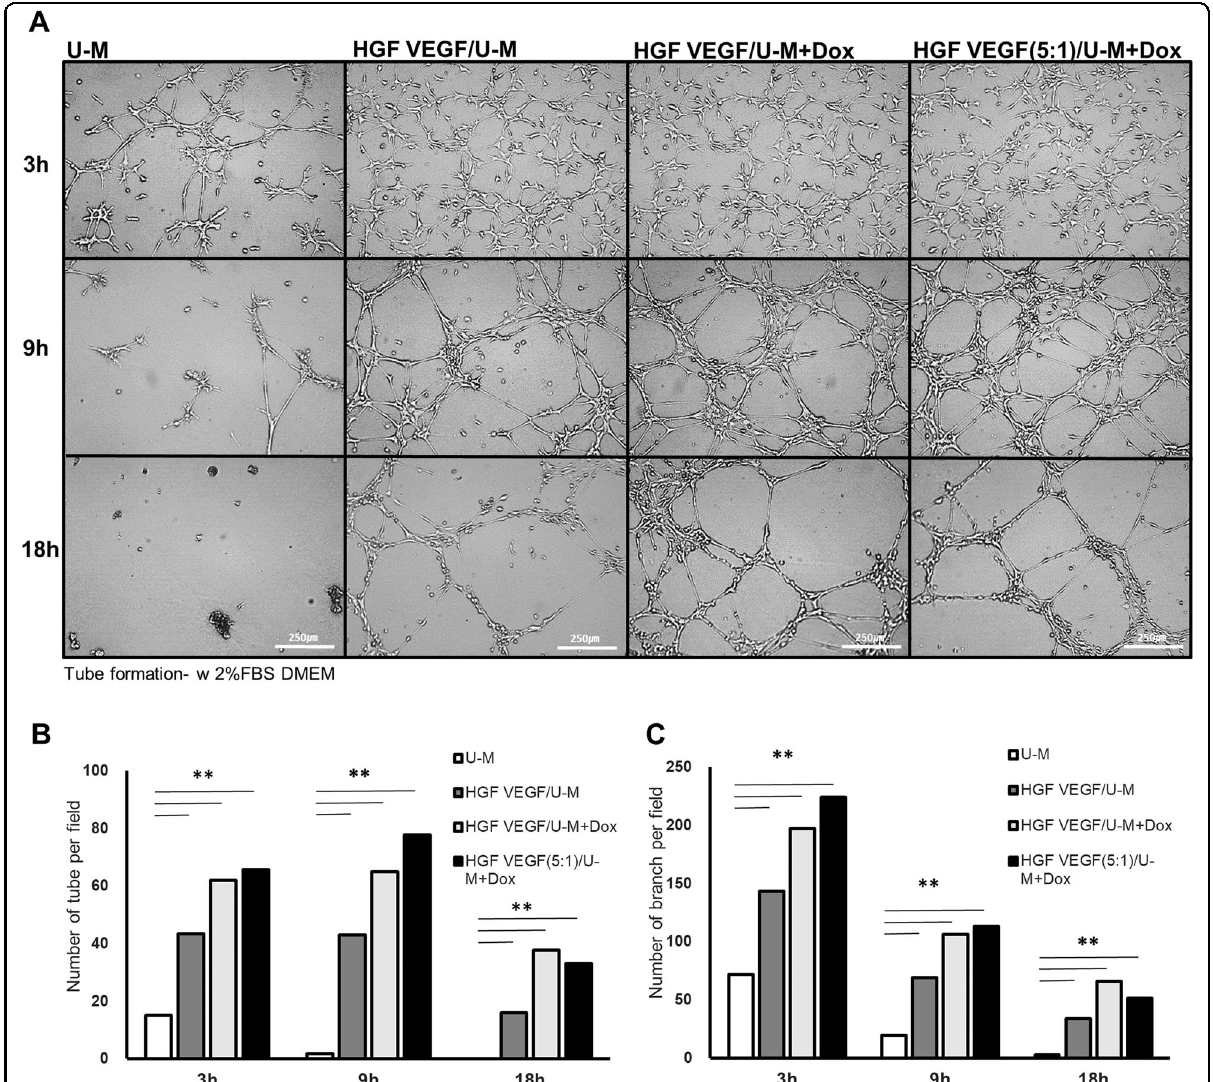
Fig. 4 HGF + VEGF/U-Ms enhanced tube formation following HGF + VEGF induction. a Images of tube formation were acquired for the U-Ms (UCB-MSCs), HGF + VEGF/U-Ms (1:1 ratio) without doxycycline (Dox) and with Dox, and HGF + VEGF (5:1 ratio)/U-Ms with Dox. b , c Tube formation was analyzed based on the number of tubes ( b ) and the number of tube branches ( c ). N =